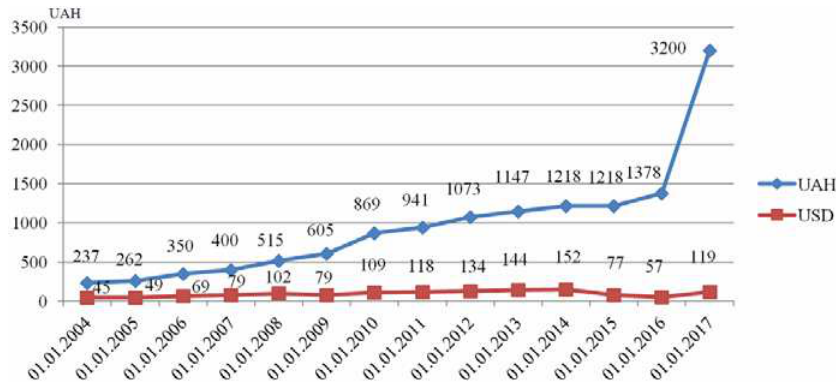
Fig. 1. Dynamic pattern of the minimum labor remuneration growth in Ukraine during the period 2004-2015 (Polischuk,